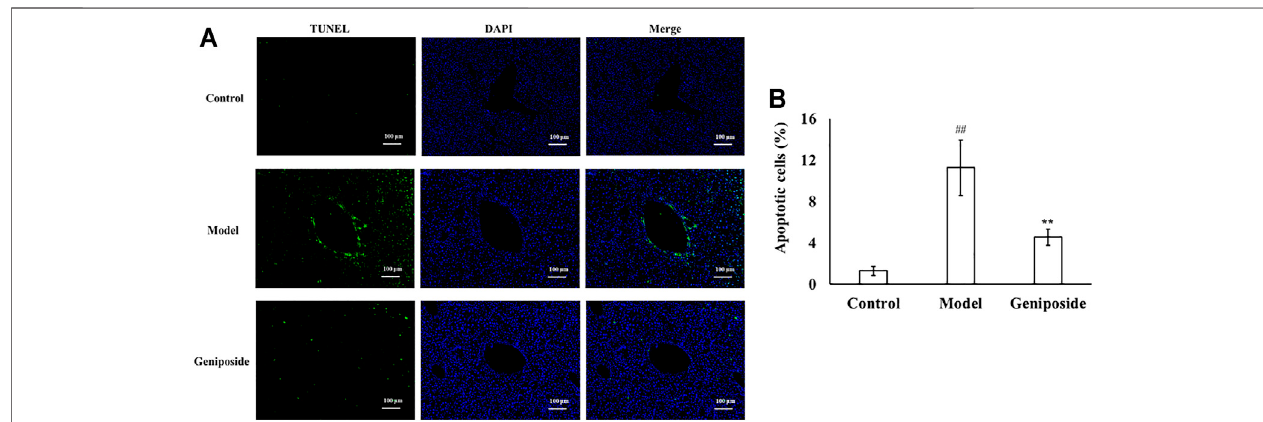
FIGURE 5 | Geniposide treatment improved apoptosis in liver fi brosis model mice. (A) Changes of TUNEL staining. (B) Changes of quantitative analysis of apoptoticcells. (A,B) TUNELstainingindicatedthatgeniposidetreatmentreducedthenumberofapoptoticcellsinaliversection.Control,model,andgeniposidegroups ( n (cid:2) 10 per group). Data are presented as mean ± SD. ## p < 0.01, Model group vs. Control group; pp p < 0.01, Geniposide group vs. Model group.